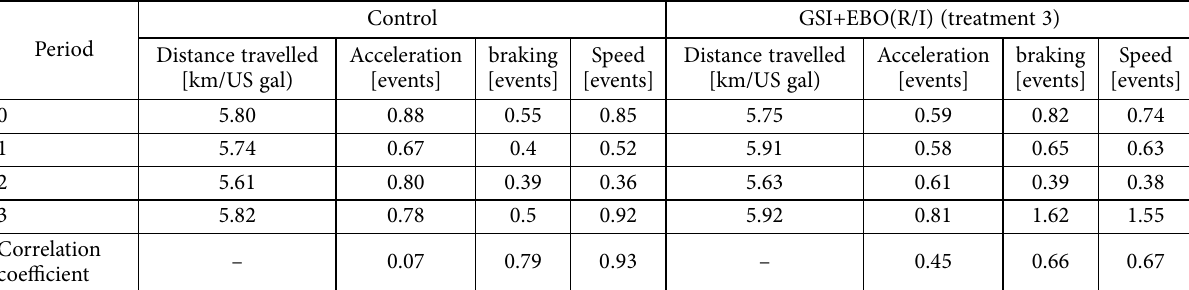
Table 7. Case Study 2, correlation of average values